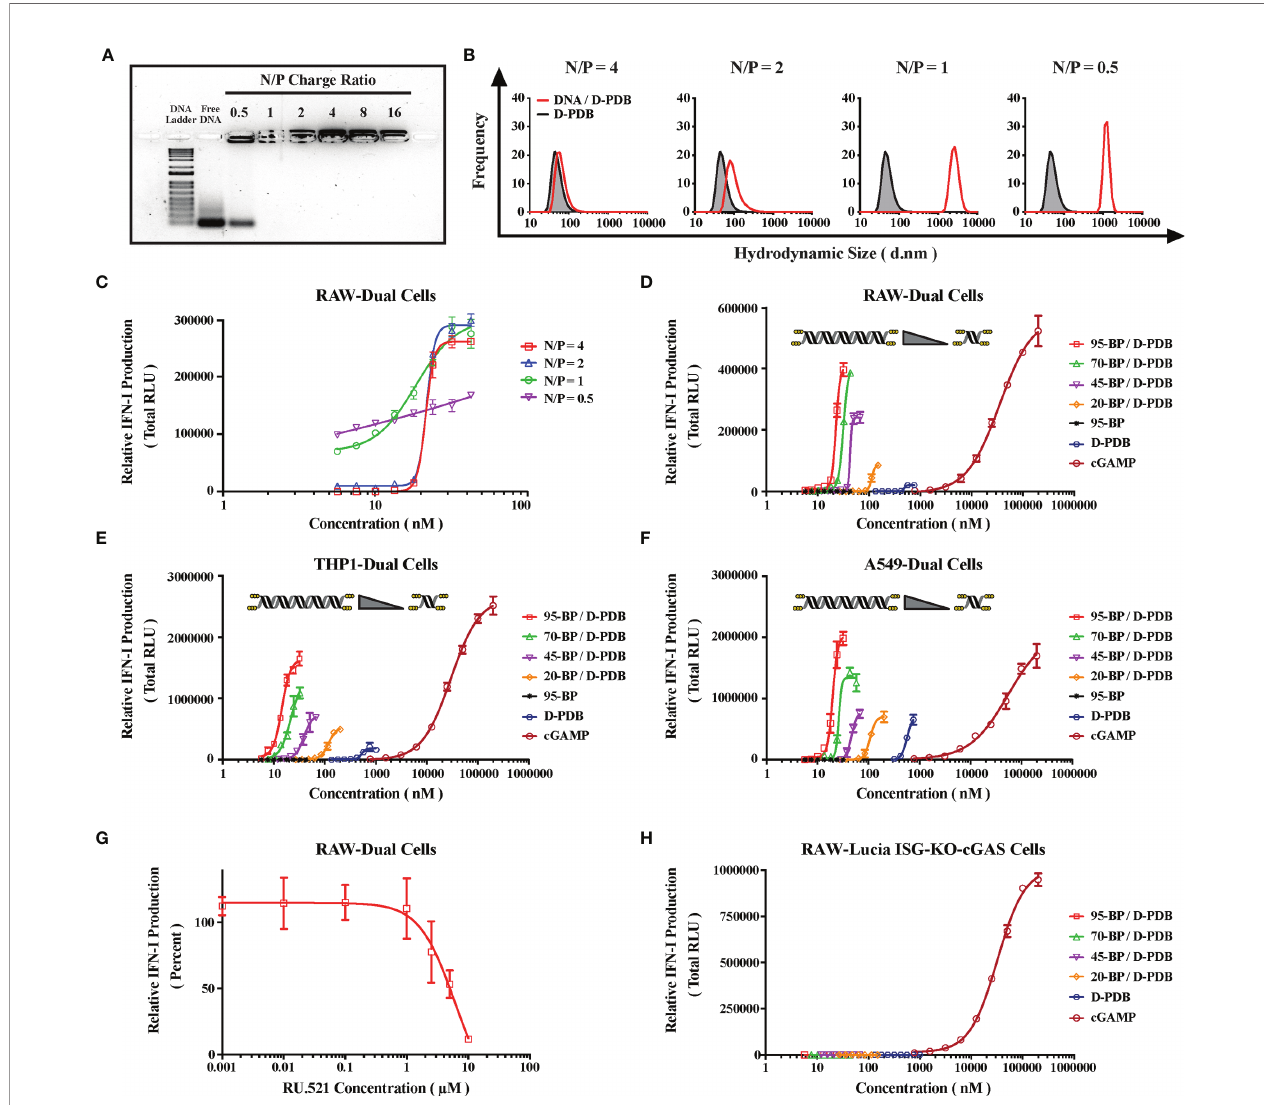
FIGURE 2 | Engineering DNA/Polymer Nanoparticles for Intracellular Activation of cGAS. (A) Agarose gel image. DNA Ladder refers to the TrackIt ™ 1 Kb Plus DNA Ladder, and Free DNA refers to uncomplexed phosphorothioate-capped 95-BP dsDNA. Lanes comprise 1 µg DNA mixed with the indicated amount of D-PDB. (B) DLS analysis of phosphorothioate-capped 95-BP dsDNA/D-PDB complexes at varying N/P charge ratios. Frequency indicates the number-based particle size distribution. Hydrodynamic size indicates the particle diameter in nm. (C) RAW-Dual reporter cell assay of phosphorothioate-capped 95-BP dsDNA/D-PDB complexes at varying N/P charge ratios. (D) RAW-Dual reporter cell assay of synthetic, variable-length ISD library complexed to D-PDB at an N/P charge ratio of 4, and indicated experimental controls were used. (E) THP1-Dual reporter cell assay of synthetic, variable-length ISD library complexed to D-PDB at an N/P charge ratio of 4, and indicated experimental controls were used. (F) A549-Dual reporter cell assay of synthetic, variable-length ISD library complexed to D-PDB at an N/P charge ratio of 4, and indicated experimental controls were used. (G) Dose response of the cGAS inhibitor, RU.521 in RAW-Dual reporter cells. After a 4 hour incubation with RU.521, cells were treated with 25 nM phosphorothioate-capped 95-BP dsDNA complexed to D-PDB at an N/P charge ratio of 4. (H) RAW-Lucia ISG-KO-cGAS reporter cell assay of synthetic, variable-length ISD library complexed to D-PDB at an N/P charge ratio of 4, and indicated experimental controls were used. The dose response curves for free D-PDB are positioned along the x-axis in terms of the molar amount of polymer chains rather than molar amount of loaded dsDNA, and each dose response that utilized the polymer was administered using equivalent D-PDB